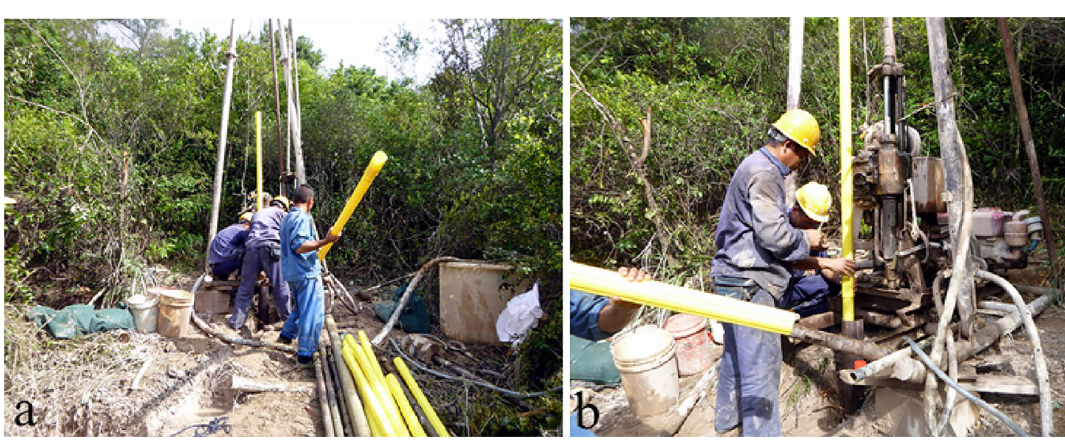
Figure 7. Installation of inclinometer